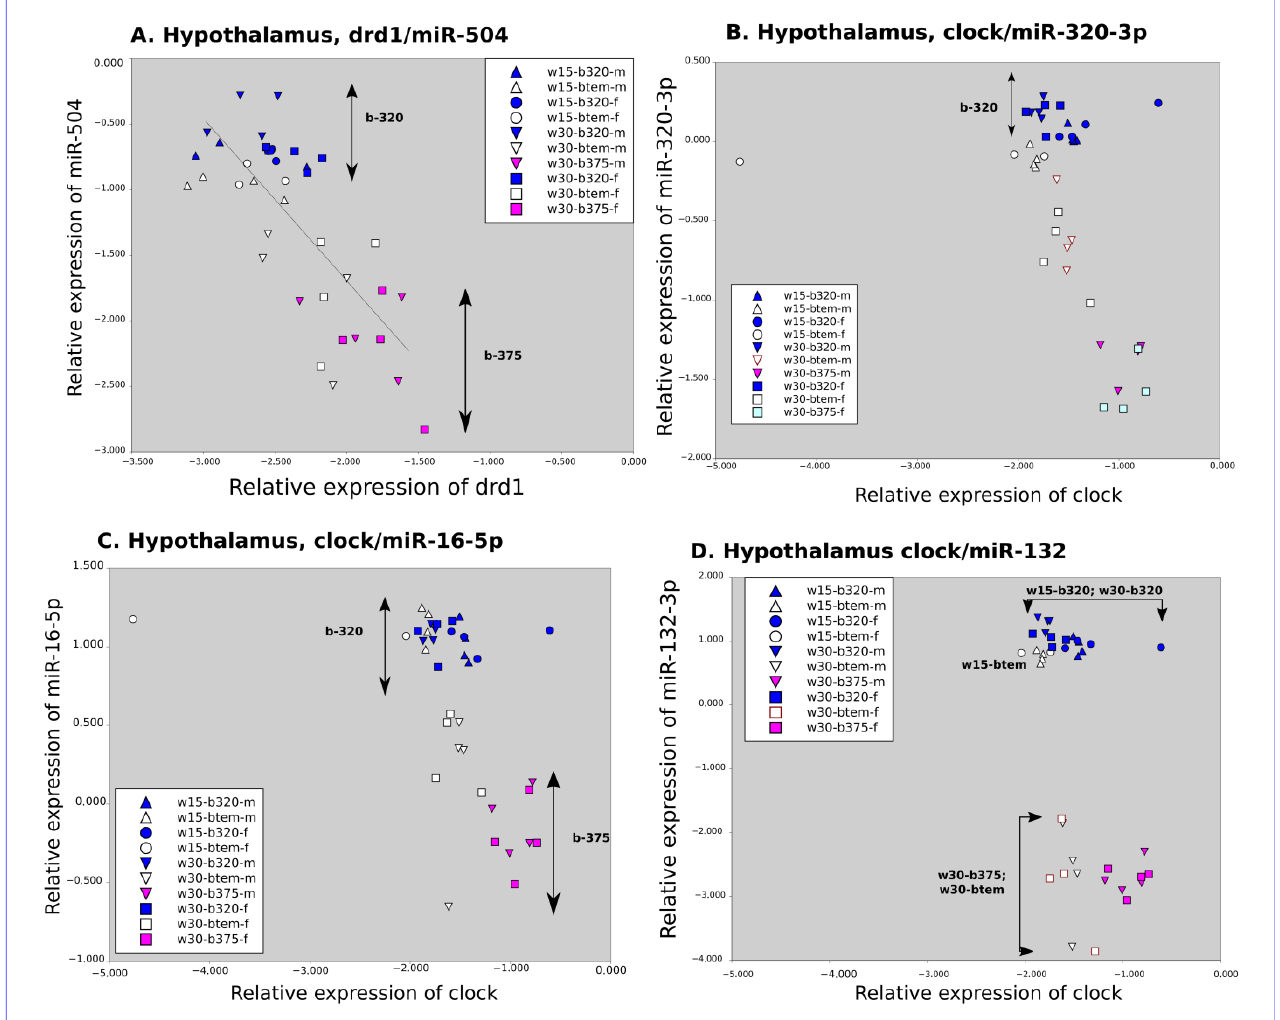
Figure 6. Long-term effects of miR-320-3p/DOSP according to early or regular weaning. Note the negative correlation (R = −0.75, linear regression in black) between miR-504 and DRD1 transcripts ( A ), and the upregulation of miR-320-3p ( B ), miR-16-5p ( C ) and 132-3p ( D ) for early weaned rats and regularly weaned rats treated by miR-320-3p/DOSP in hypothalamus cell extracts. indicates that rats were sacrificed in the dark phase. 2.5. Long-Term Effects Induced by miR-375-3p/DOSP, with Subsequent Regular Weaning (Figure 1C) Neither miR-375-3p nor miR-320-3p showed changes in expression in rat pups force- fed with miR-375-3p/DOSP compared to those fed with DOSP vehicle in the stomach (Fig- ure 7A) and duodenum (Figure 7B) . However, the gastric relative levels of chga , pparg , IL10 , pax4 , pax6 , and TNG-alpha were downregulated, and foxa was upregulated (Figure 4A).